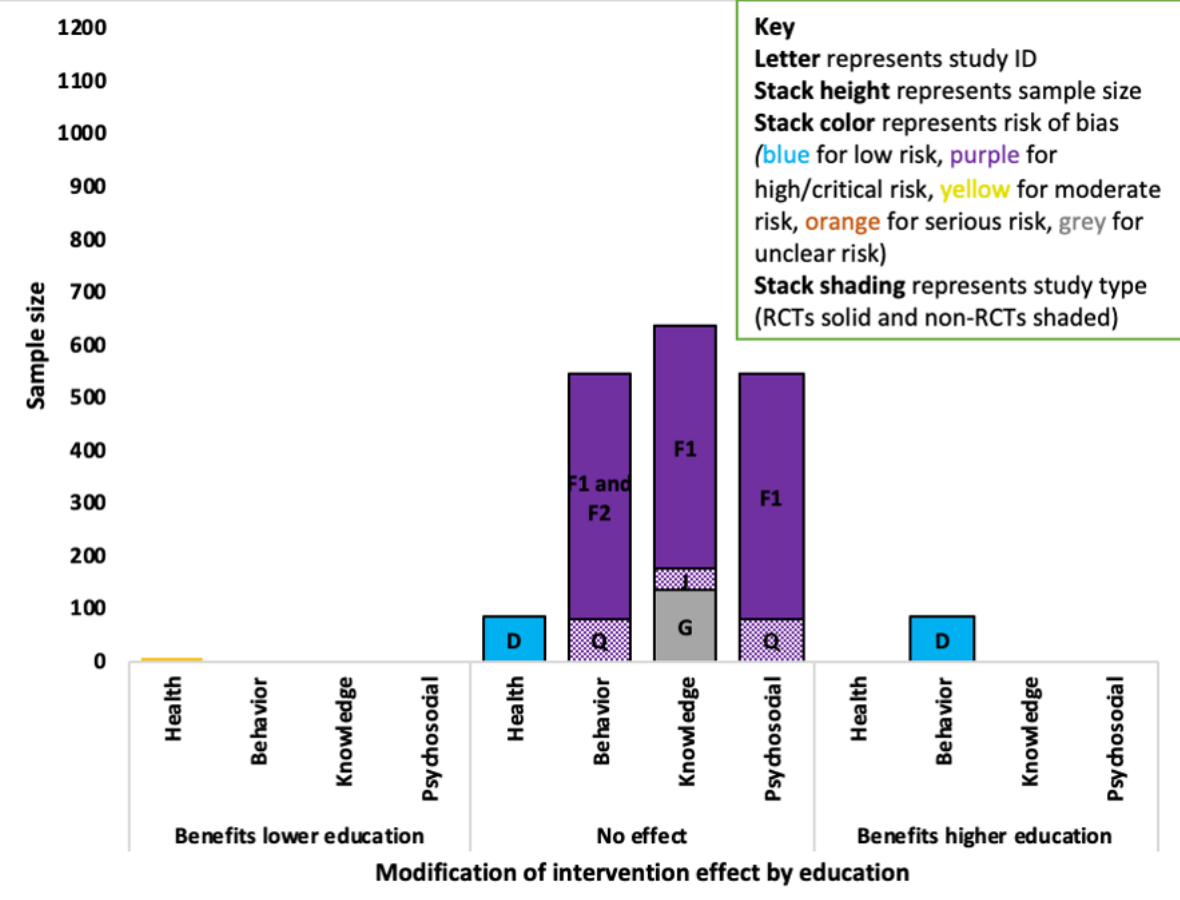
Figure 7. Adapted Harvest plot for higher education modifying intervention effects across outcomes in diabetes studies. RCT: randomized controlled